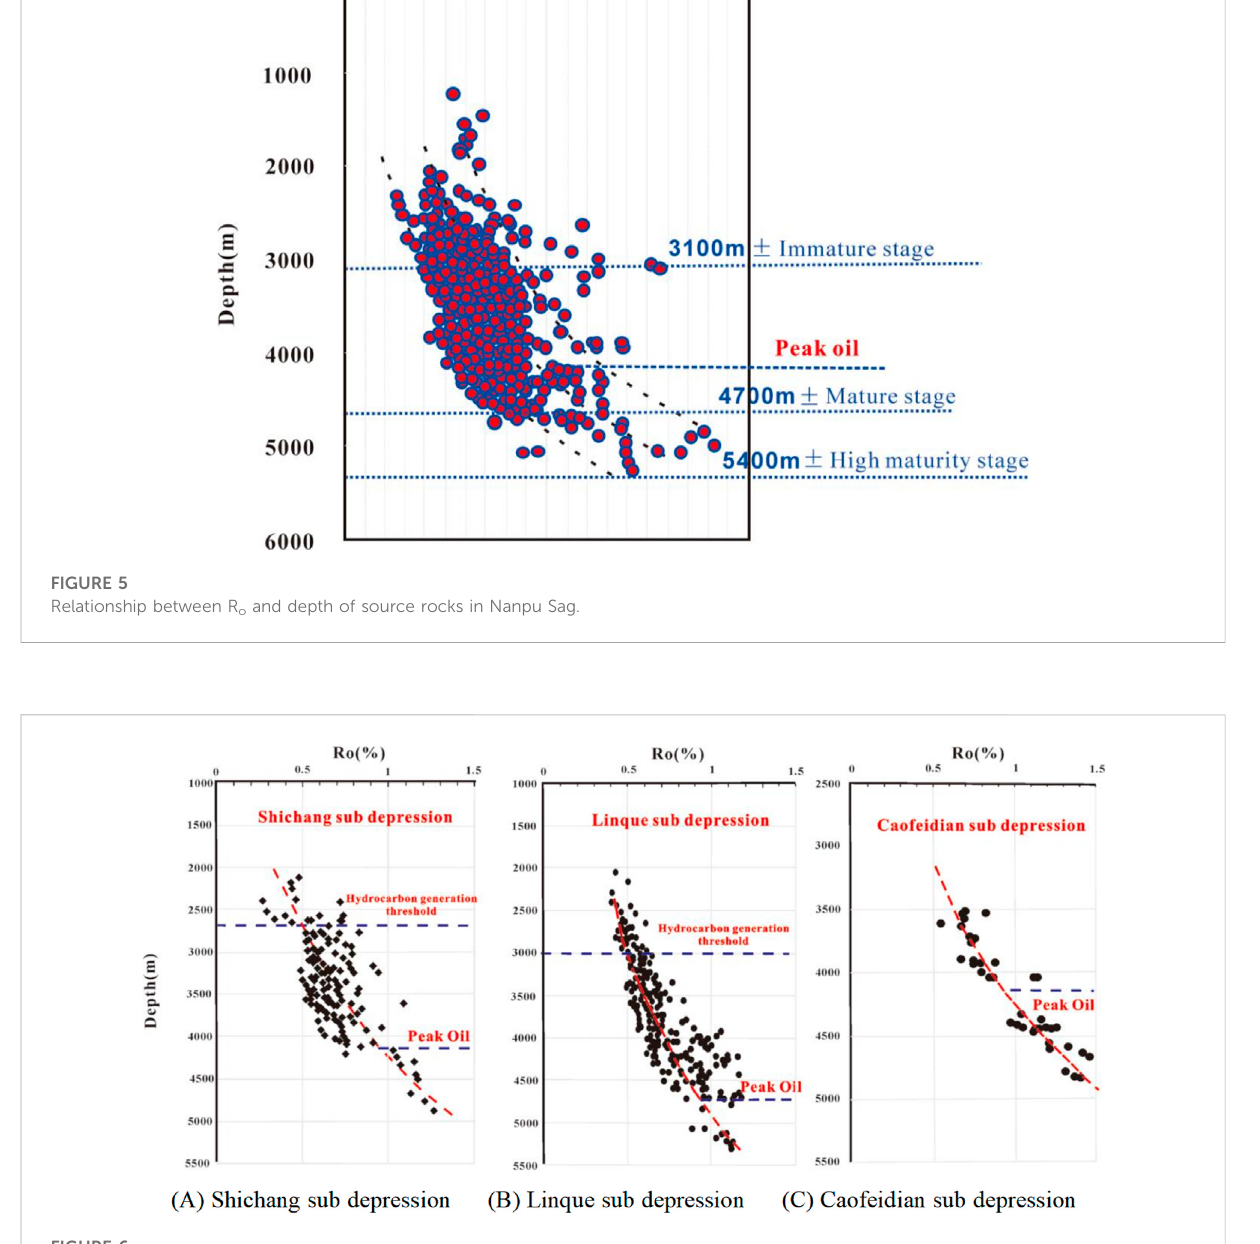
Frontiers in Earth